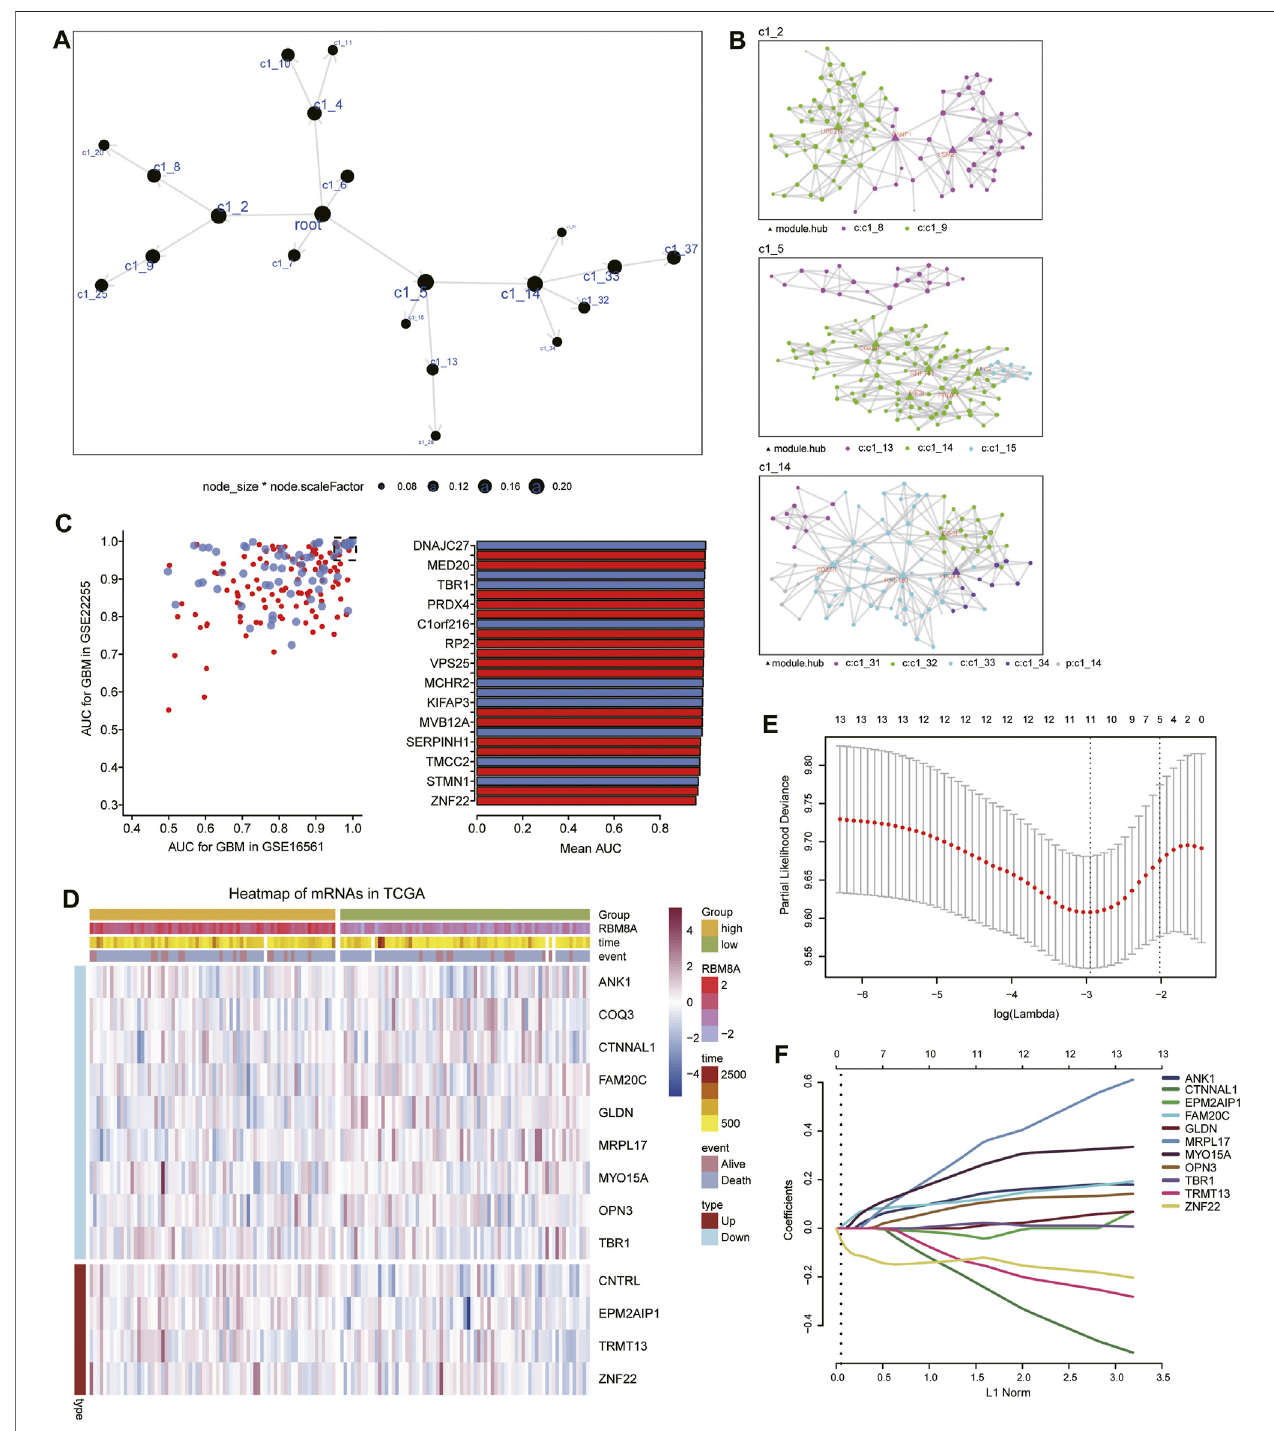
FIGURE 6 | Identi fi cation of candidate mRNAs. (A) The MEGENA coexpression network of common mRNAs. Nodes represent different modules: the larger the node, the greater the number of module genes. (B) Child modules in the MEGENA network featuring the largest number of module genes. Different colors represent different modules, while triangles represent hub genes of modules. (C) Module genes with areas under the receiver operating characteristic curve (AUCs) > 0.95 in both TCGAandGSE16011. (D) Heatmap of13genesrelated tooverallsurvivalinRBM8A high andRBM8A low patients. (E) Selectionoftheoptimal lambdaparameter via minimum criteria in the LASSO regression model. (F) LASSO coef fi cient pro fi les of 11 genes with non-zero coef fi cients.